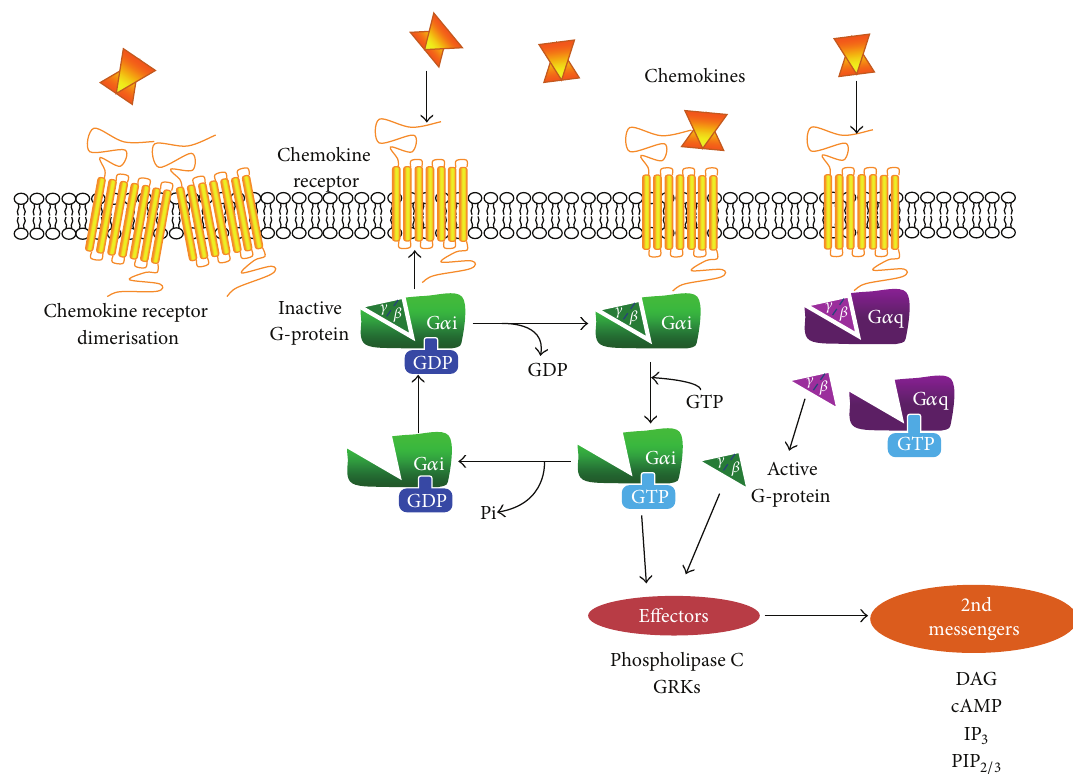
Figure 1: Schematic summary of chemokine-mediated GPCR signalling. Chemokine binding to thereceptor induces conformational changes in its transmembrane domain to allow it to couple to a heterotrimeric G-protein. Chemokine receptors predominantly couple to G 𝛼 i proteins (green)butalso G 𝛼 qproteins(purple).Chemokines alsointeract withtheirreceptorsto inducetheformationofreceptor dimersoroligomers. ThisinducesGDPtoGTPexchangeatthenucleotidebindingsiteoftheG 𝛼 subunit.ThiscausesthedissociationoftheGTP-boundG 𝛼 subunit from the G 𝛽𝛾 heterodimers and the activation of downstream signalling effectors. This leads to the production of second messengers which further propagate signal transduction pathways that cause a cellular response. Inactivation of the G-protein occurs through hydrolysis of GTP, allowing the G 𝛼 -GDP to recombine with the 𝛽𝛾